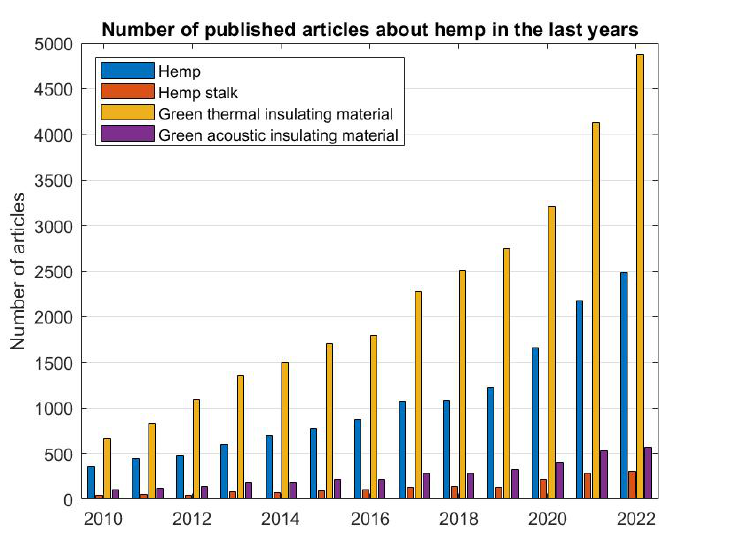
Figure 1. Number of articles published in ScienceDirect and MDPI about hemp and green insula- tion